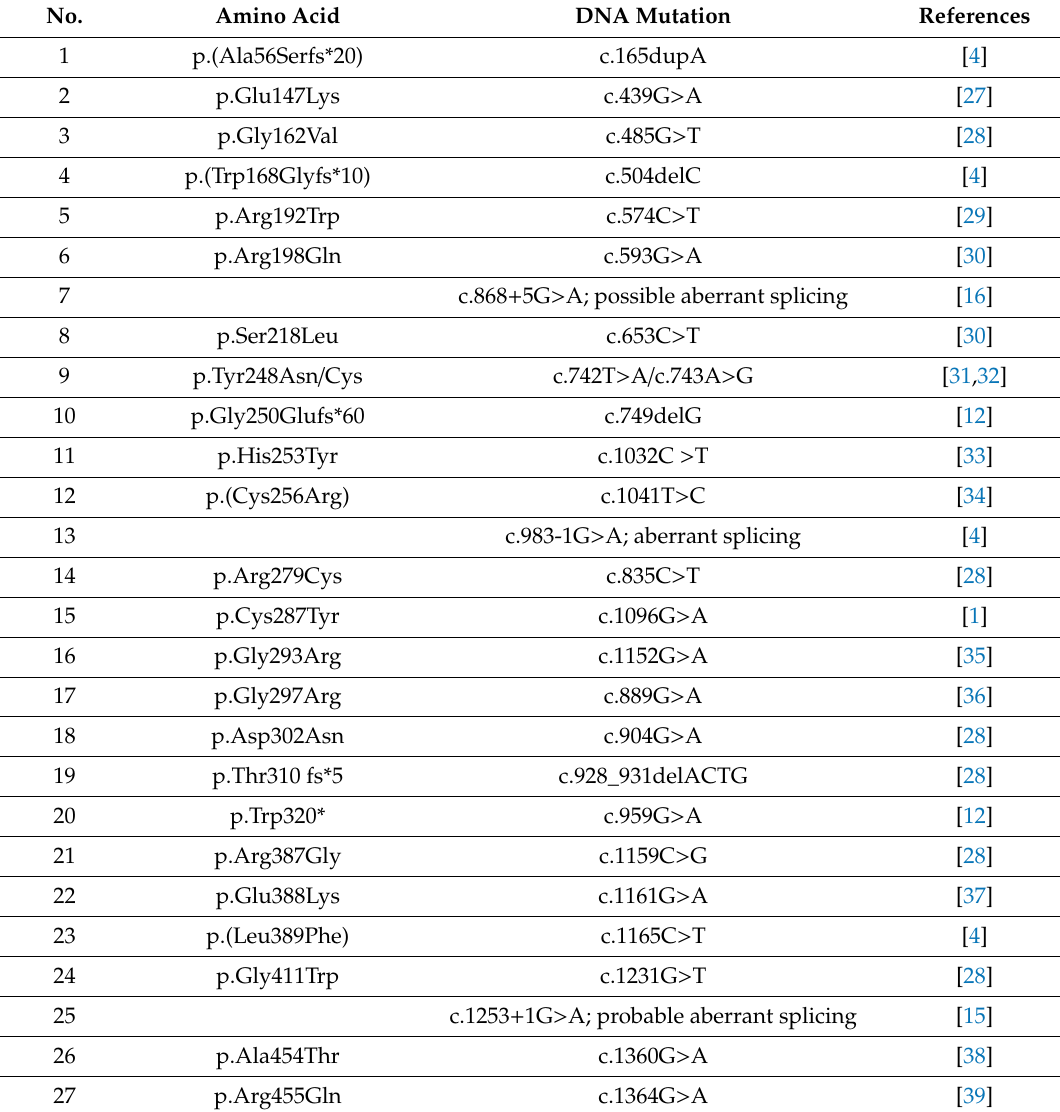
Table 1. List of Ca V 2.1 mutations causing